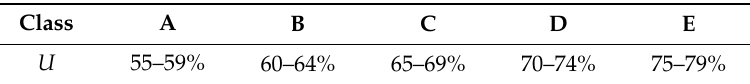
Table 2. Di ff erent classes of tool wear uniformity